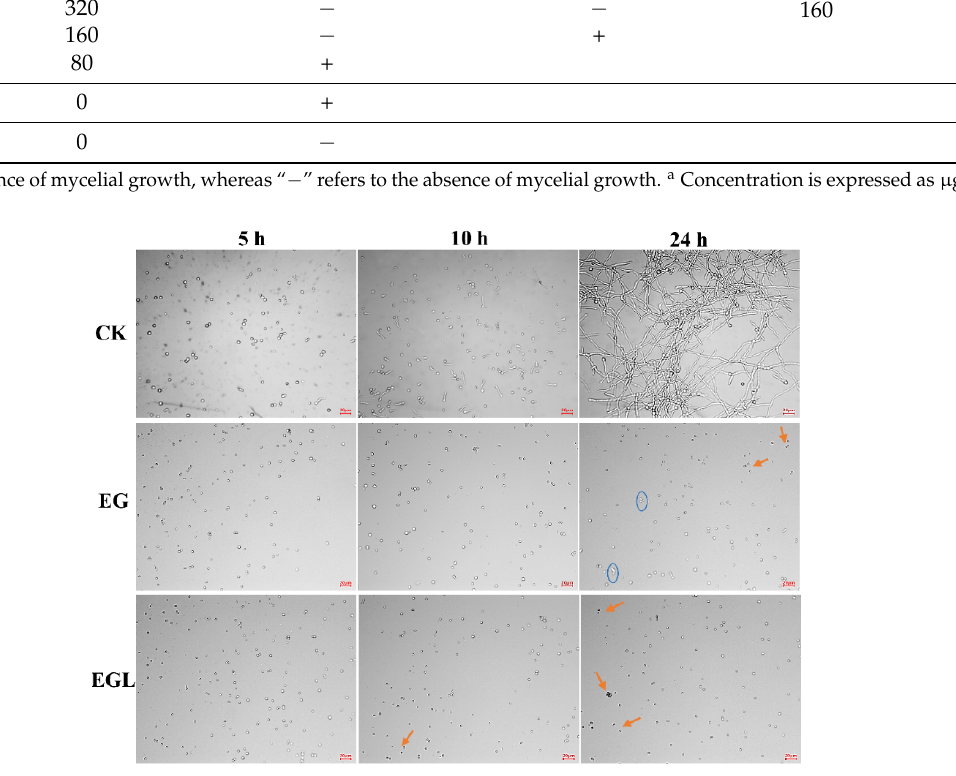
Figure 2. Optical microscopy of the spore germination after treatment with water (CK),